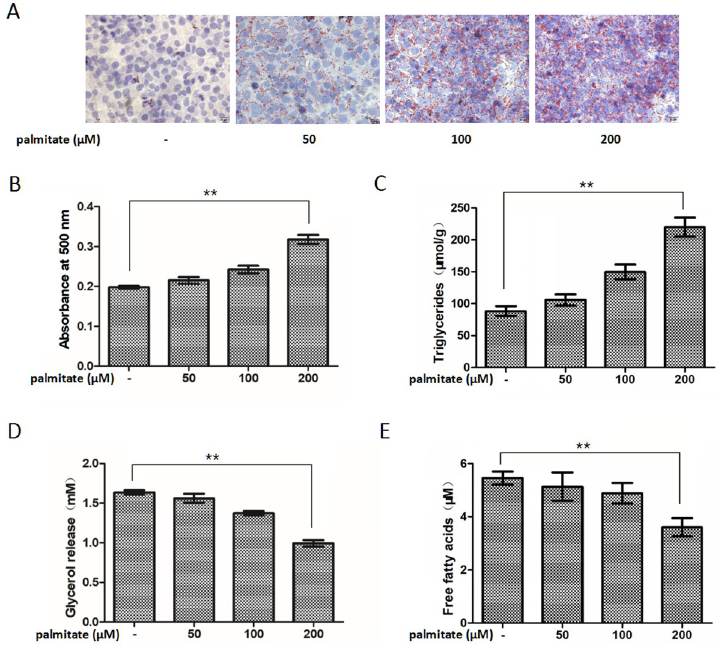
Fig 1. Palmitate promoted lipid accumulation and inhibited lipolytic activity in a concentration-dependent manner in HepG2 hepatocytes. Intracellular lipid accumulation was developed (A) by oil red O staining and (B) assessed by the optical density value of the collected oil red O dye. Original magnifying, 400 × . Scale bars = 20 μ m. (C) Intracellular lipid accumulation was measured by intracellular triglyceride assay. Lipolytic activity was determined by (D) the glycerol and (E) FFAs content in the cell media. Each bar represents the means ± SDs (n = 3). � P < 0.05, �� P < 0.01.